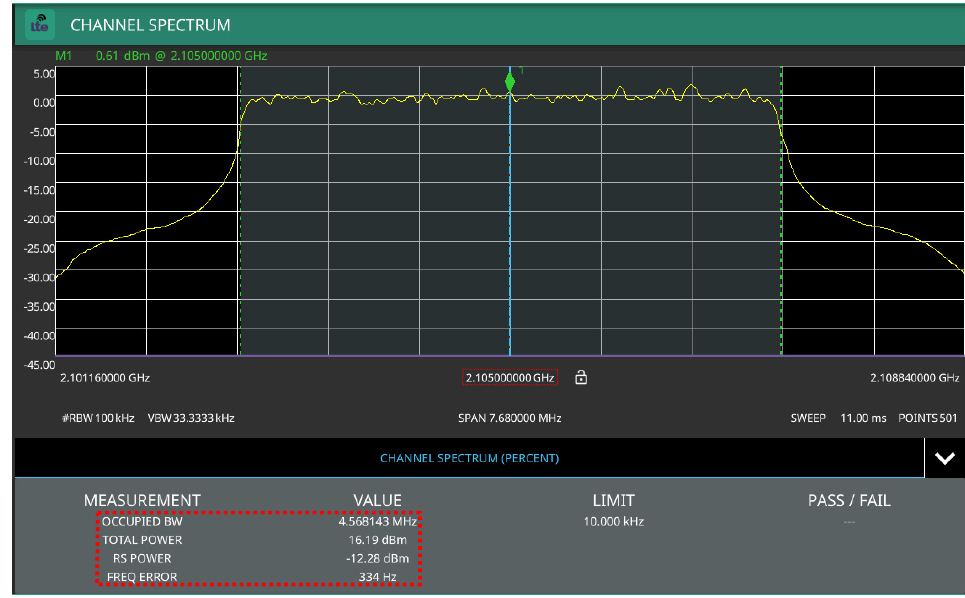
Figure 6. Bandwidth occupied by the signal transmitted by the emulated